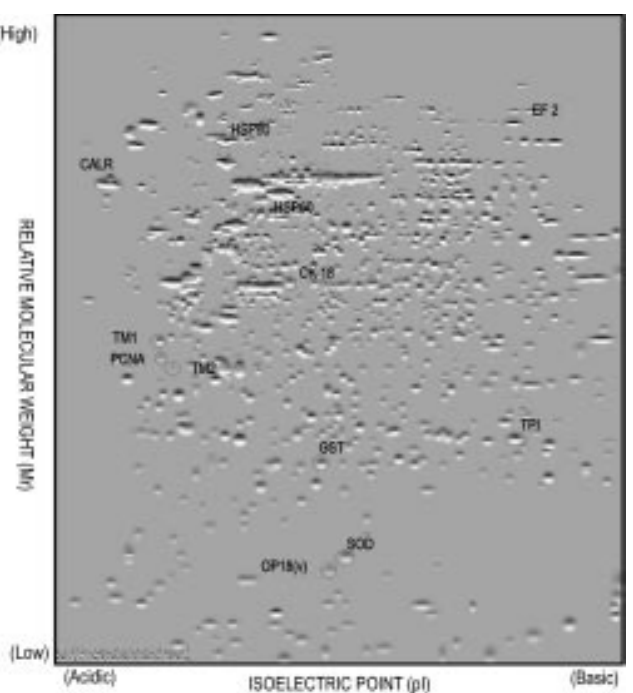
Proteins showing qualitative and quantitative differ- ences in their level of expression between prostate